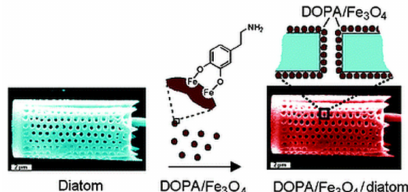
Figure 11. Scheme of functionalization of diatoms with dopamine-modified iron oxide nanoparticles to introduce their magnetic properties. Reproduced from [63], copyright (2010), with permission from The Royal Society of